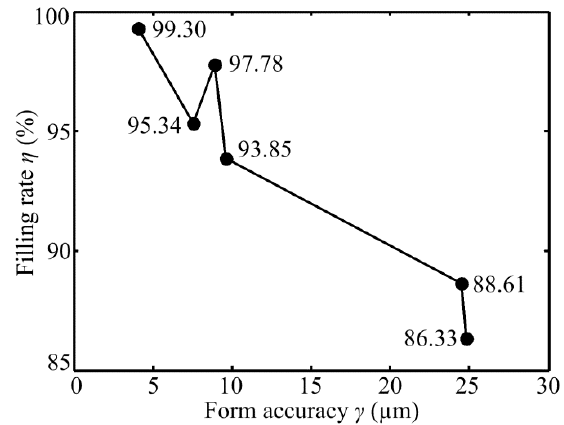
Figure 12. The relationship between the filling rate of micro-structured polymer η and form accuracy of micro-ground mold core γ .